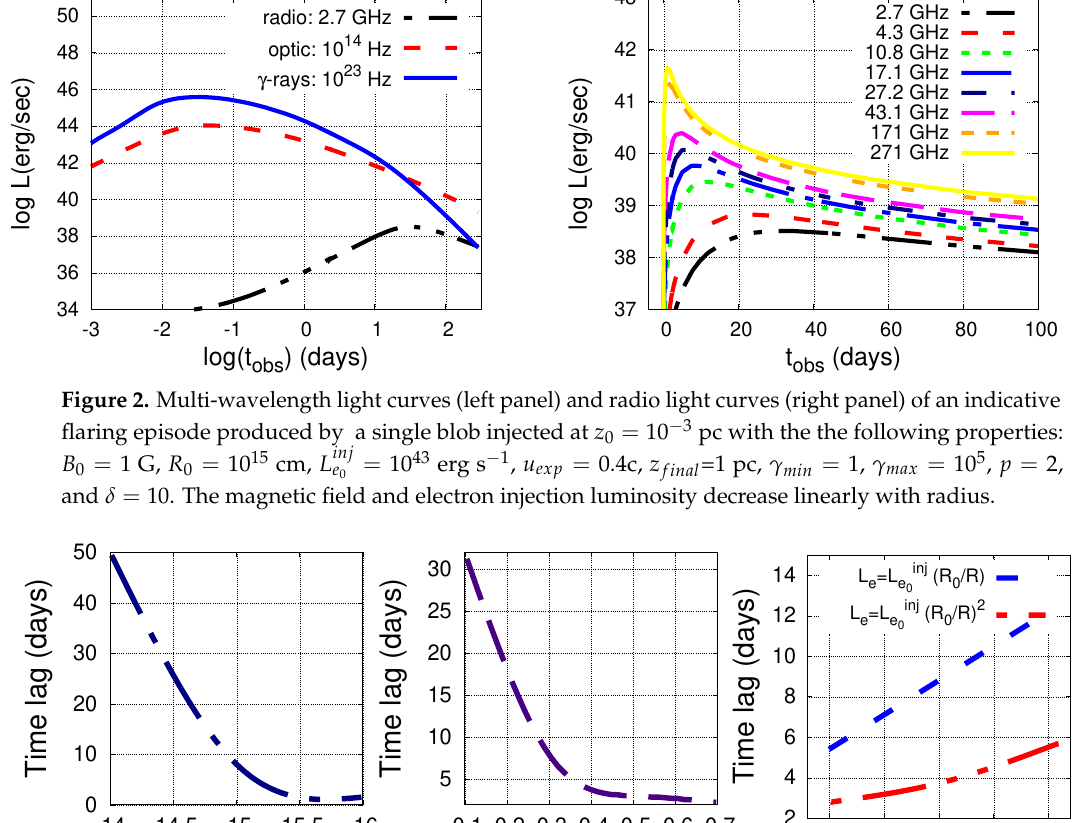
for two different radial dependences 0